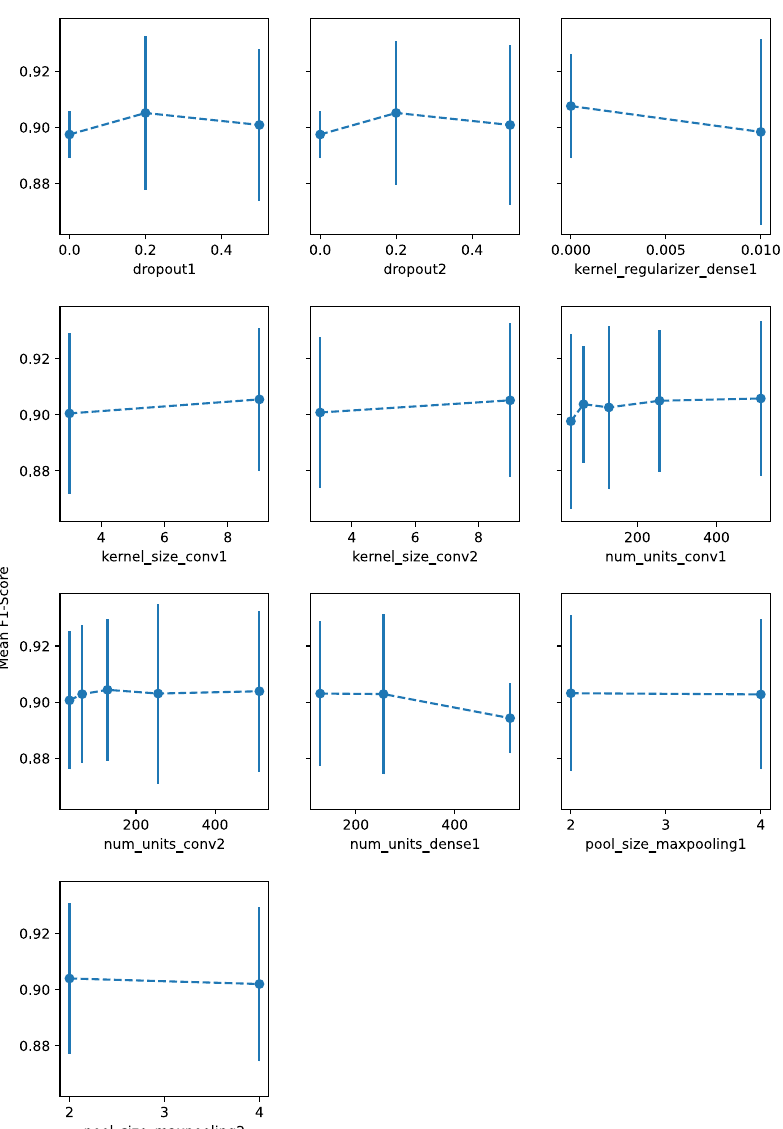
Figure 10. Mean test performance of CNN models for respective evaluated hyperparameters with standard